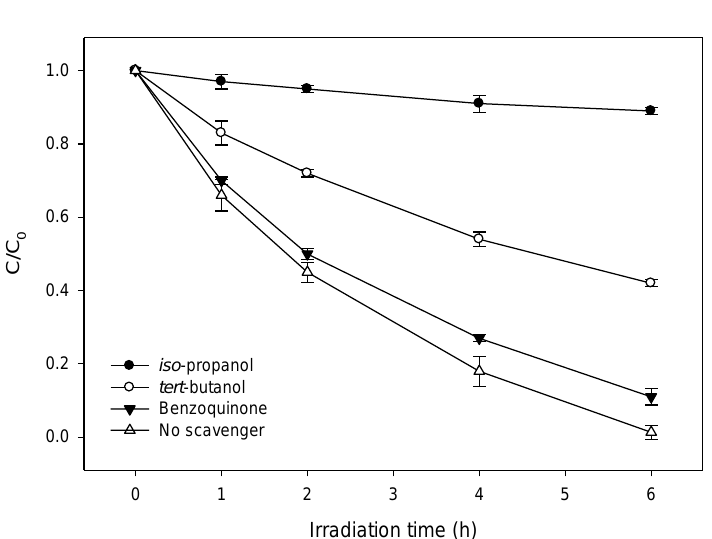
Figure 5. The role of • OH, SO 4 •− , and O 2 •− in the simulated solar light-activated TiO 2 / S 2 O 82 − / H 2 O 2 photocatalysis of lindane. [lindane] 0 = 1.0 µ M; [iso-propanol] 0 = 50 mM; [tert-butanol] 0 = 50 mM; [benzoquinone] 0 = 50 mM; mass of TiO 2 film = 9.02 mg; thickness of TiO 2 film = 1.02 µ m; area of TiO 2 film = 3750 mm 2 ; pH = 5.8.